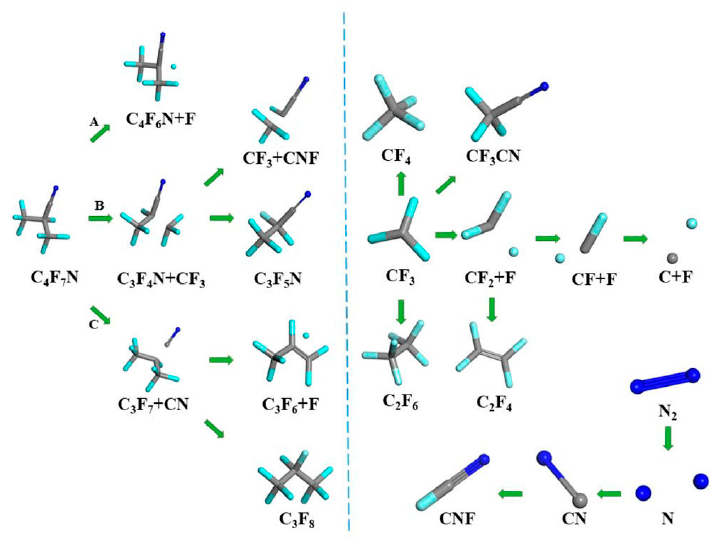
Figure 6. Probable decomposition pathways of C 4 F 7 N / N 2 [56].